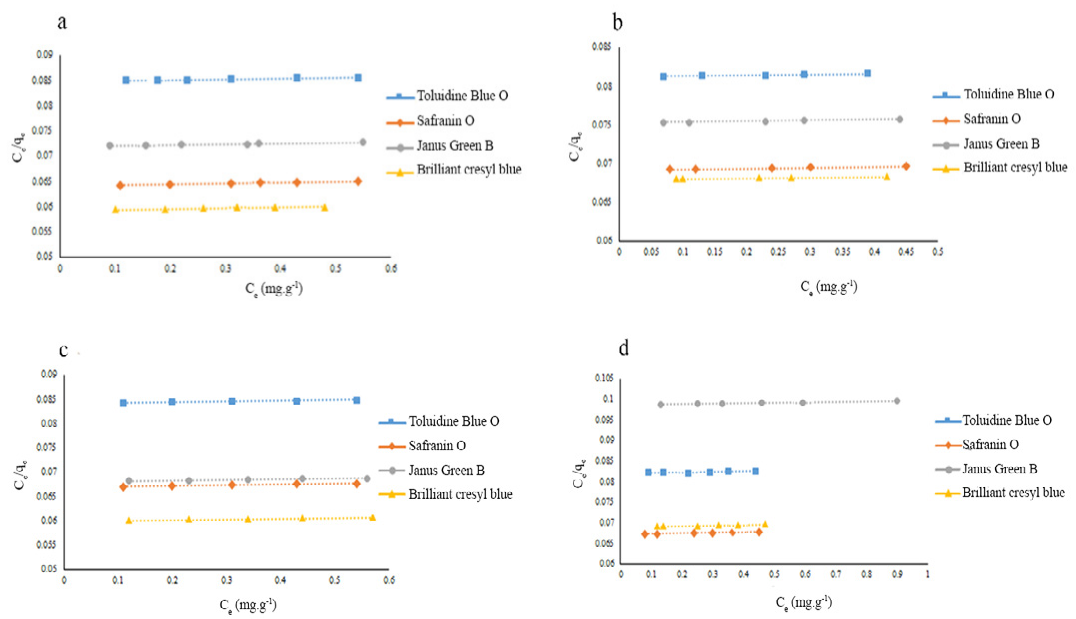
Fig. 4 . Langmuir plots for the adsorption of dyes over sorbents at different temperatures: TMU-16-NH respectively) and TMU-16 ((c), (d) at 308 and 318 K,